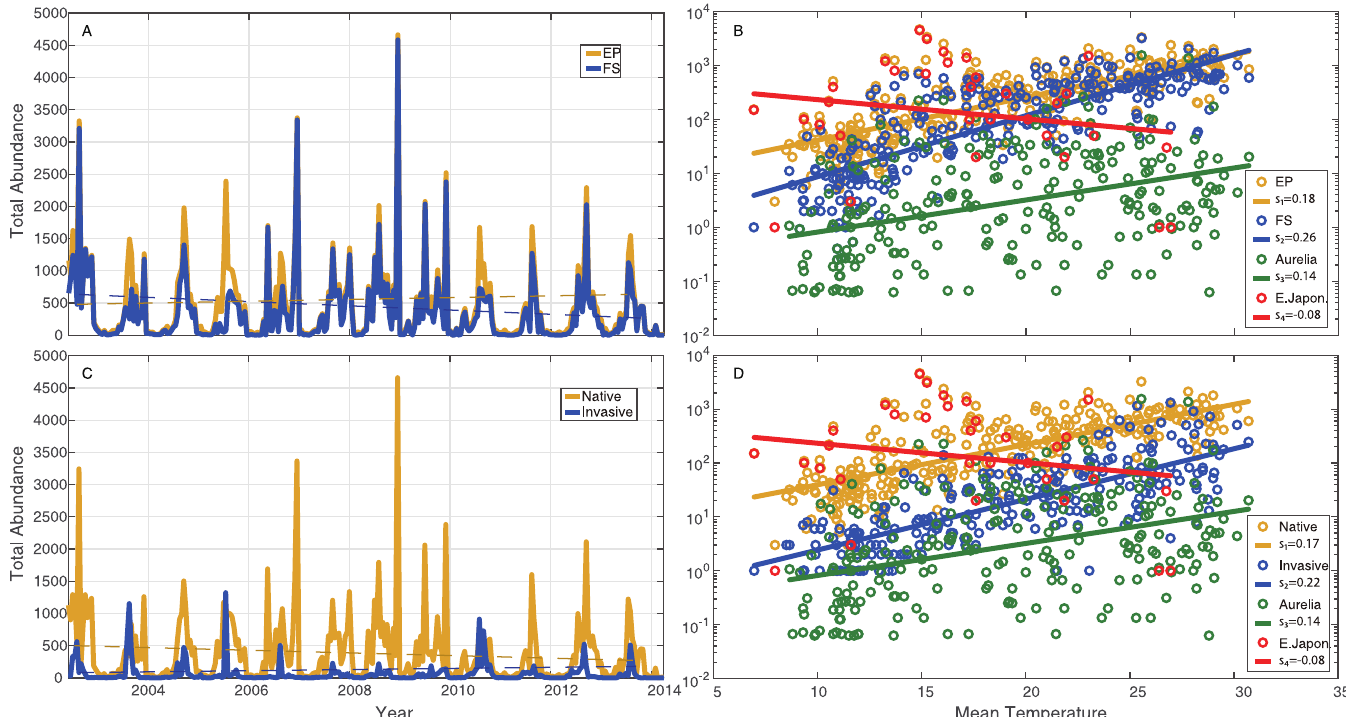
Fig 2. Total species abundance of EP, FS, native and invasive species over time and mean temperature. Total species abundance of EP (yellow) and FS (blue) species over time and temperature ( A and B ). Total species abundance of native (yellow) and invasive (blue) species over time and temperature ( C and D ). Abundance of species 1 (green) and 2 (red) over mean temperature ( C and D